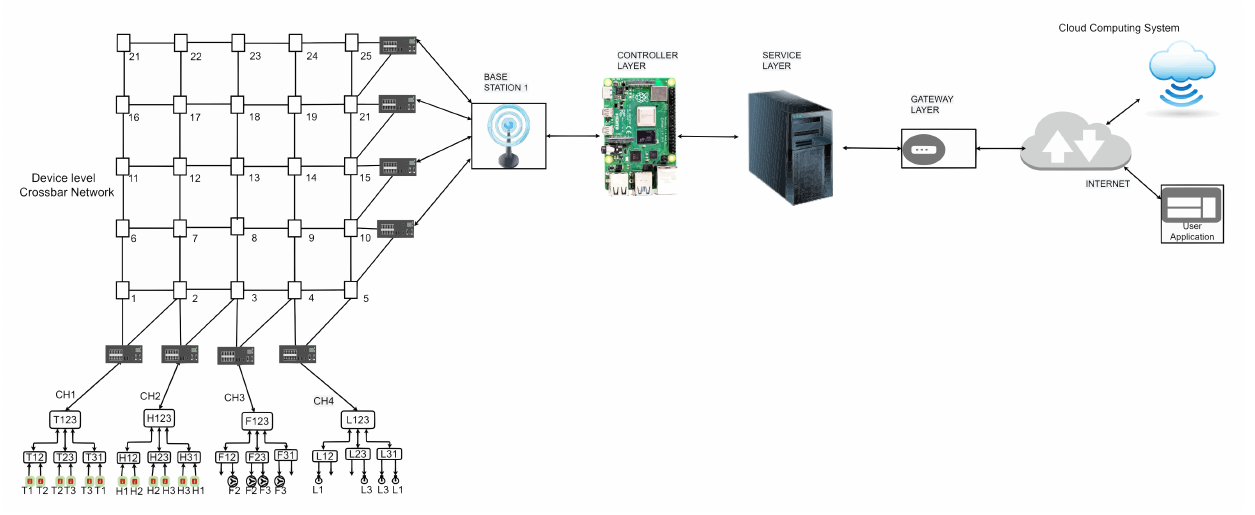
Figure 2. Sample IoT network with a single base